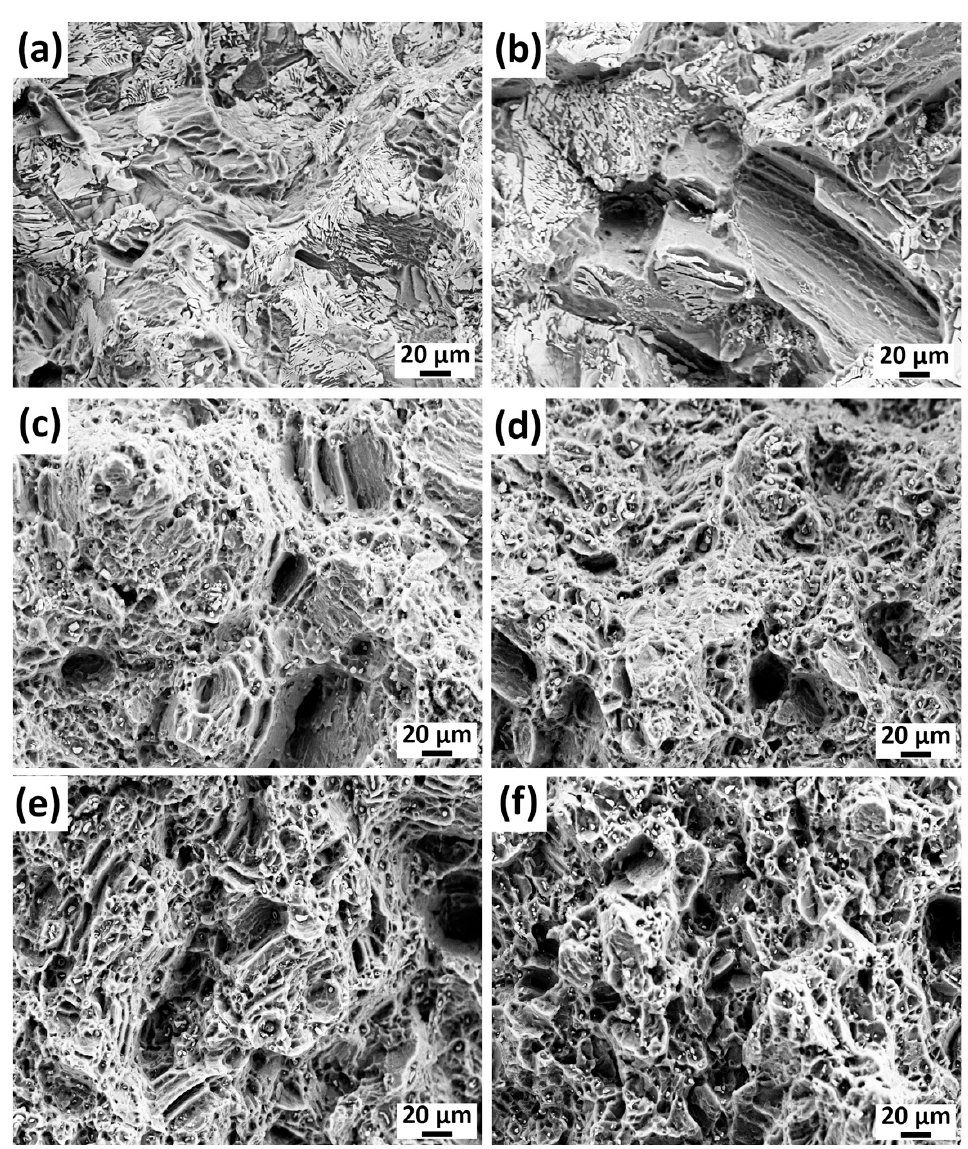
Figure 10. SEM micrographs of the fractured surfaces after tensile tests: ( a ) as-cast, ( b ) homogenized, extruded at ( c ) 250 °C, ( d ) 300 °C, ( e ) 350 °C, and ( f ) 400 °C.